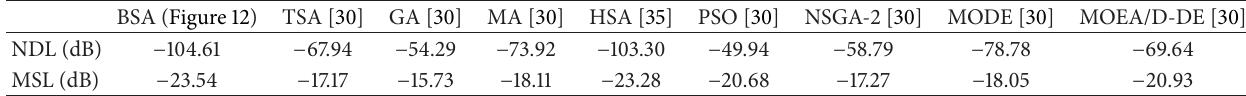
Table 6: NDL and MSL values obtained by BSA and other optimization techniques TSA [30], GA [30], MA [30], HSA [35], PSO [30], NSGA-2 [30], MODE [30], and MOEA/D-DE [30] for 22-element linear antenna array with imposed one null at 9 ∘ .